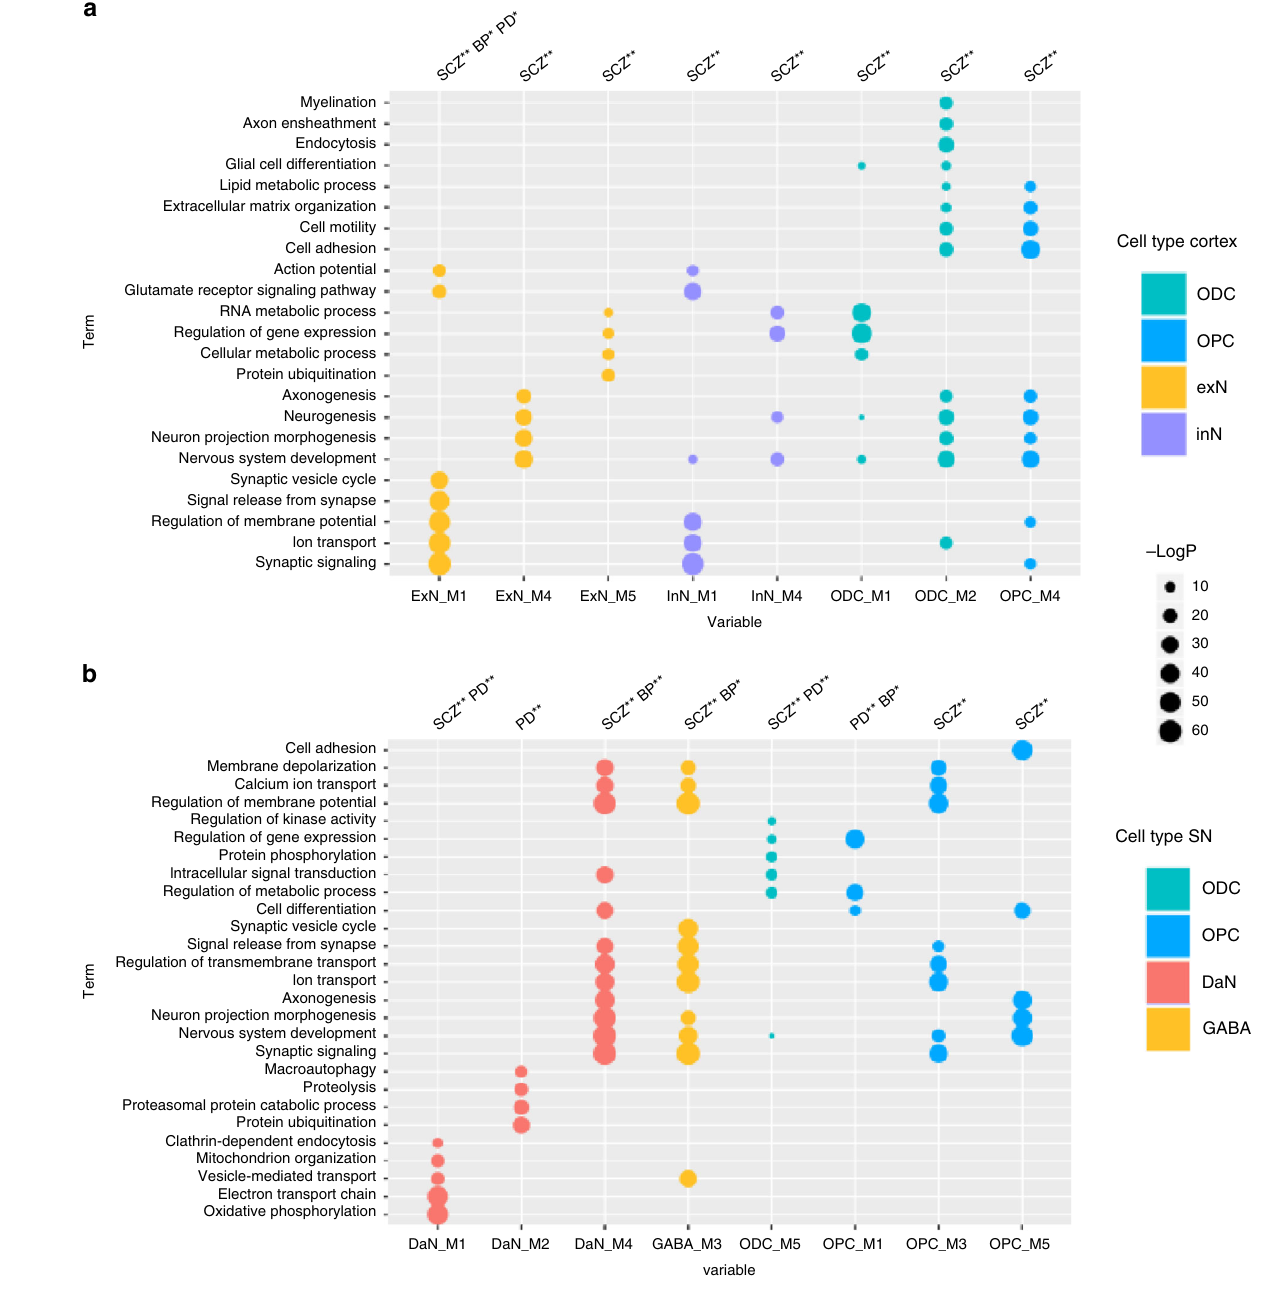
Fig. 4 Cell-type-speci fi c pathways associated with the genetic risk of three genetic brain disorders. Gene Ontology (GO) enrichment for cortex ( a ) and substantia nigra (SN) ( b ) cell-type-speci fi c protein – protein interaction (PPI) gene modules enriched in Parkinson ’ s disease (PD), schizophrenia (SCZ) and bipolar (BP) disorders risk. We tested the convergence of disease genetic risk at a functional level across cell-type-speci fi c PPI gene modules using MAGMA gene set analysis (one-sided positive two-sample t -test); an asterisk (*) and double asterisks (**) indicate nominally signi fi cant p value (<0.05) and q value (Bonferroni correction for the number of cell-type PPI modules tested), respectively. The top representative GO biological process terms are shown for cell-type modules with either PD, SCZ or BP risk enrichment that reached signi fi cance in the more general cell-type level analysis (Fig. 2). Tests across all identi fi ed gene modules are reported in Supplementary Fig. 10, and complete lists of enriched GO terms are reported in Supplementary Data 6 and 7. The size of circles represents − log( p value) for GO enrichment with Fisher test; colours correspond to cell types (DaNs dopaminergic neurons, Ex excitatory neurons, GABA GABAergic neurons, In: inhibitory neurons, ODC oligodendrocytes, OPC oligo-precursor